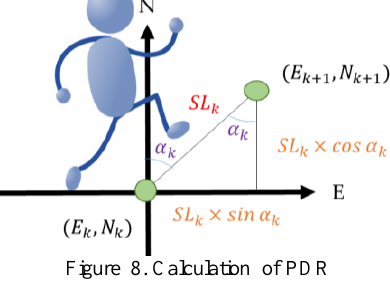
Figure 8. Calculation of